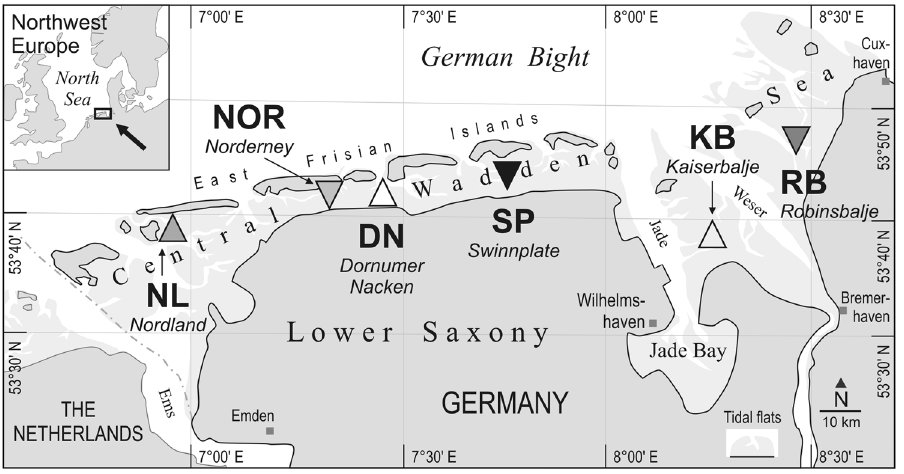
Figure 2. Location of study sites in the intertidal of the Central Wadden Sea, German Federal State Lower Saxony, southern North